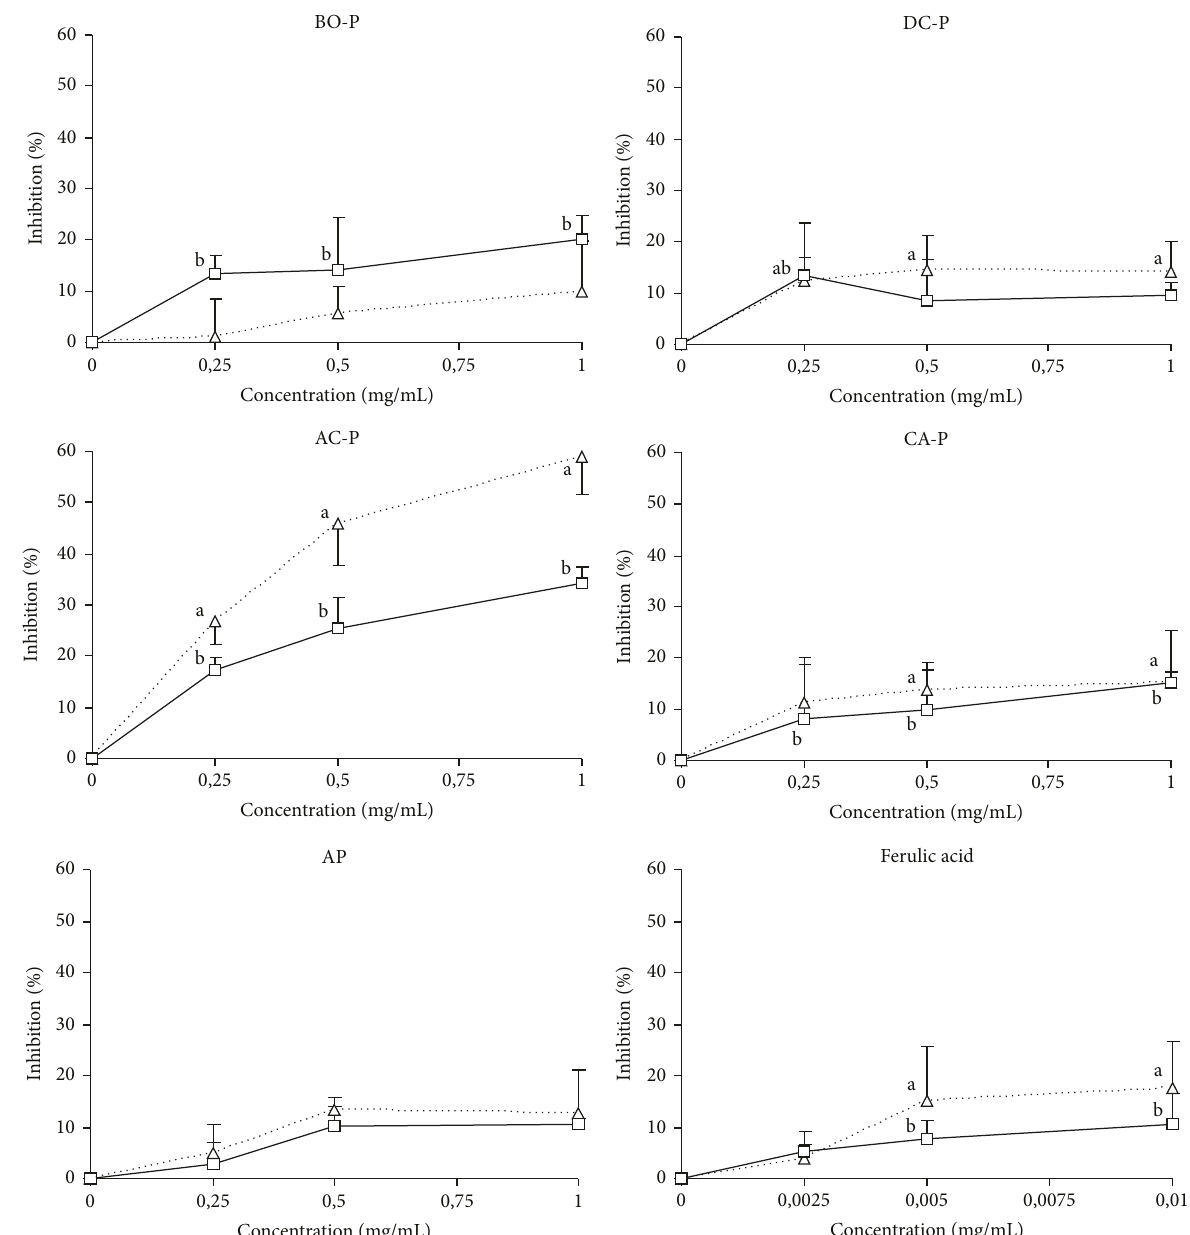
Figure 2: The inhibition of xanthine oxidase (dotted line) and reduction of ferricytochrome c (solid line) by pectin fractions and ferulic acid. a , b Value is significantly higher than control (𝑝 < 0.05; 𝑛 = 3 - 4) .